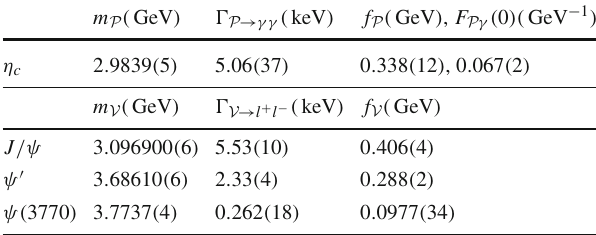
Table 3 Experimental values of selected charmonia states. The values of meson masses and decay widths are taken from the PDG [65]. The values of decay constants and the transition from factor are calculated from the corresponding decay widths according to Eqs. (33), (48), and (40) with α em = 1 / 134 ( α em = 1 / 137) for the vector meson dilepton decay(the pseudoscalar meson diphoton decay). The uncertainties of the converted values are calculated by propagation from those of the meson masses and the decay widths. The numbers in parentheses are the uncertainties, and they apply to the preceding significant digit